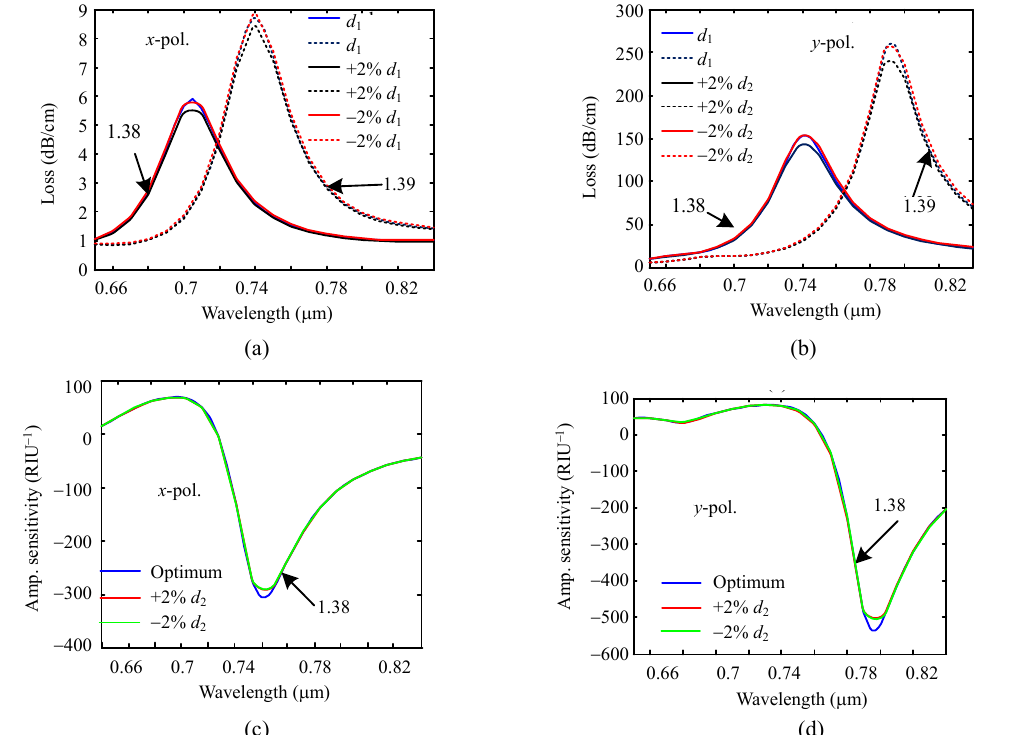
Fig. 10 Loss spectra as a function of wavelength for: (a) x - and (b) y -polarized modes, amplitude sensitivity as a function of wavelength for (c) x - and (d) y -polarized modes while d 2 is changed by ± 2%.